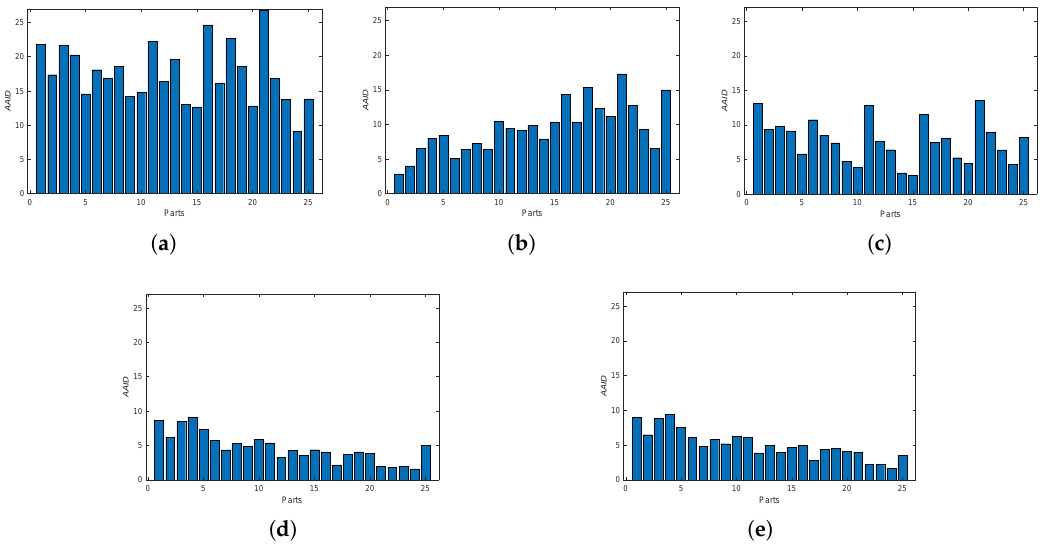
Figure 19. Spatial partition of the AAID evaluation for Concord image. ( a ) MI. ( b ) PSNR. ( c ) NCC. ( d ) Proposed (Demp). ( e ) Proposed(PCR6).